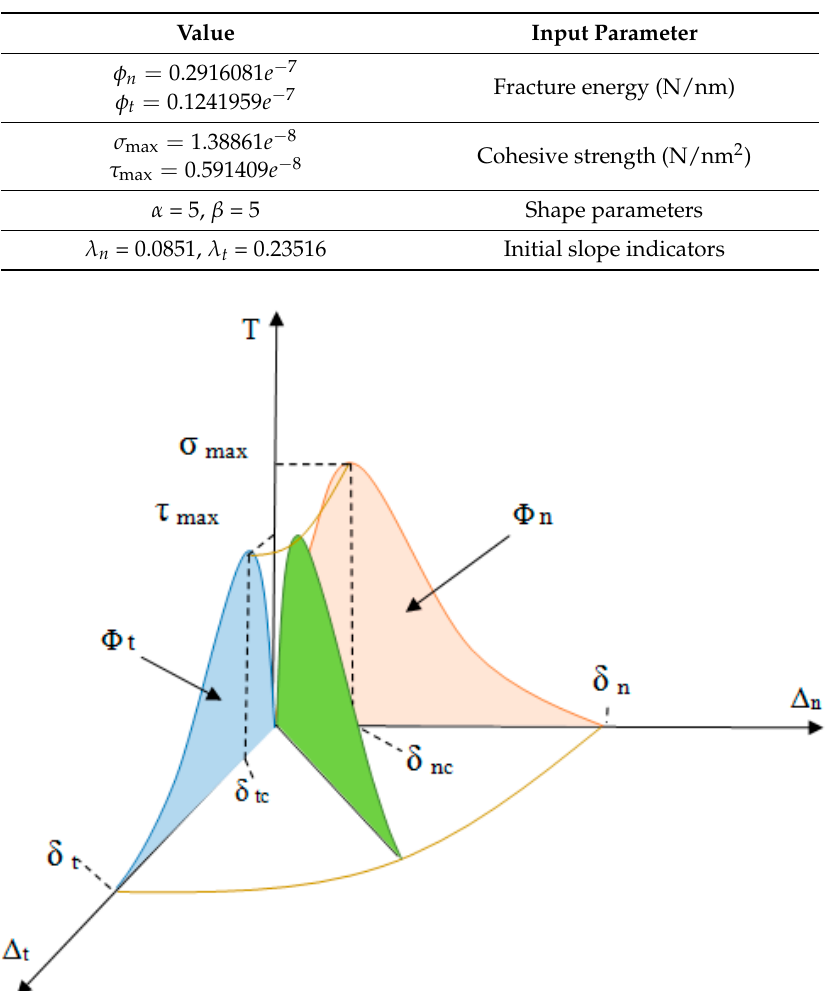
Figure 4. Normal and tangential mixed-mode response of the cohesive element in a three-dimensional state.